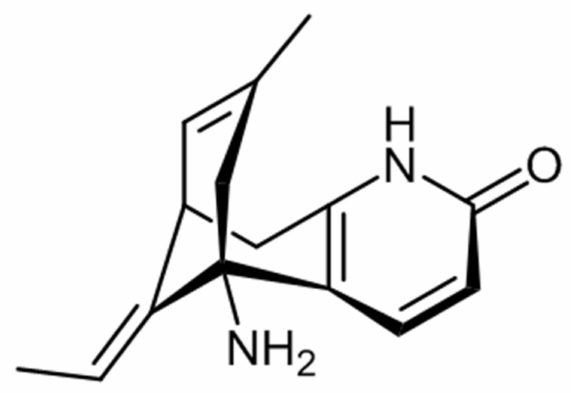
Figure 1. Chemical structure of the huperzine A